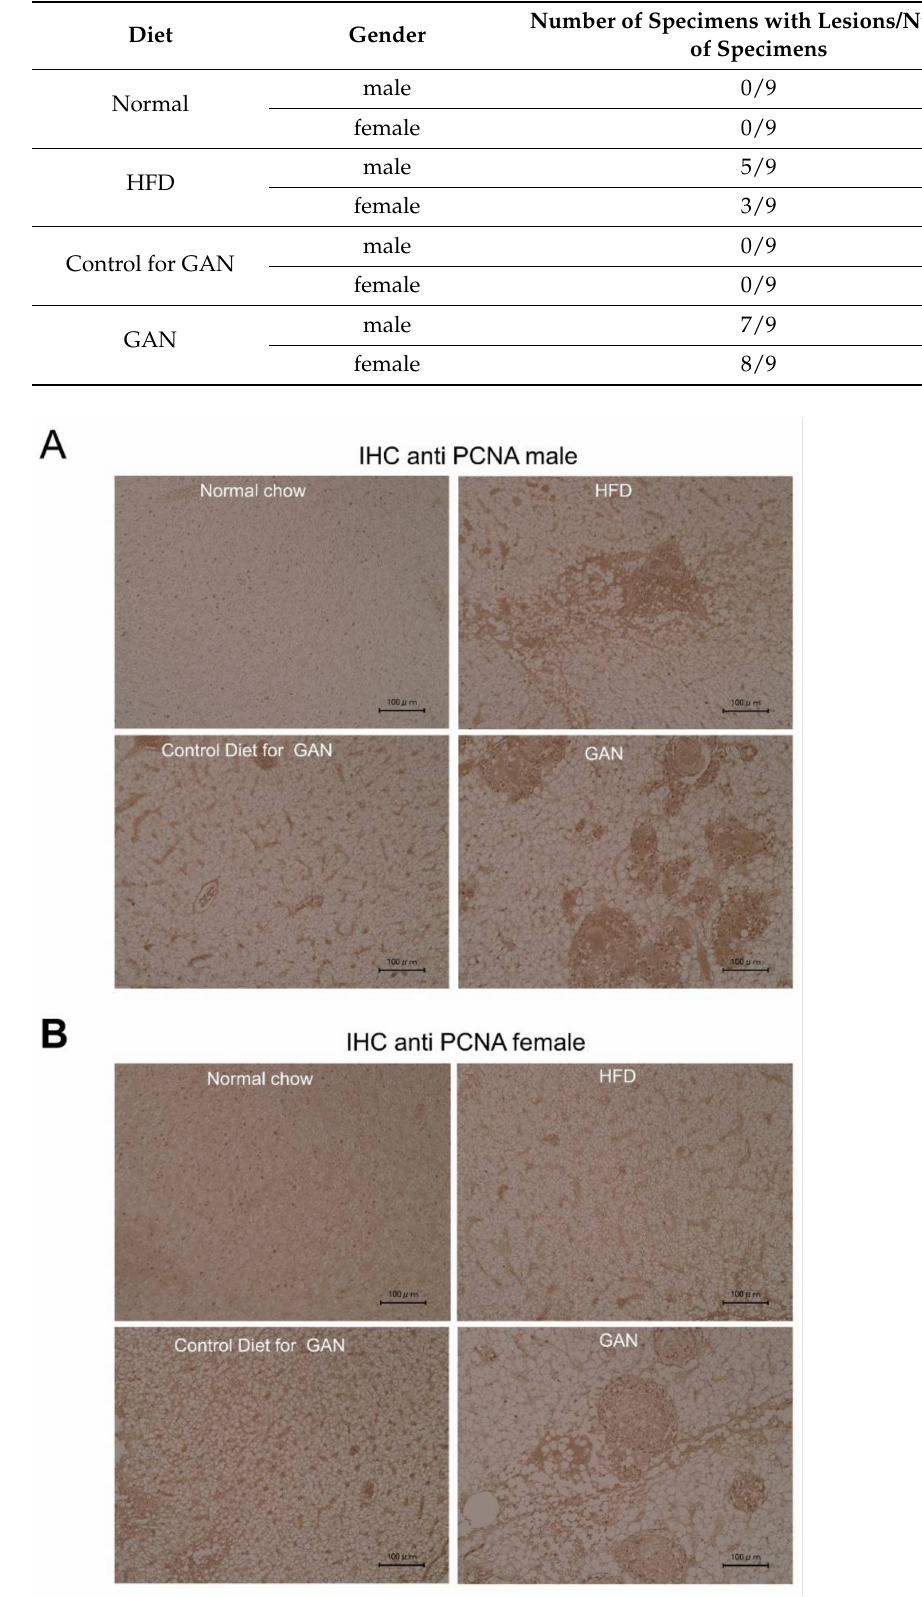
Table 1. Frequency and number of lesions.